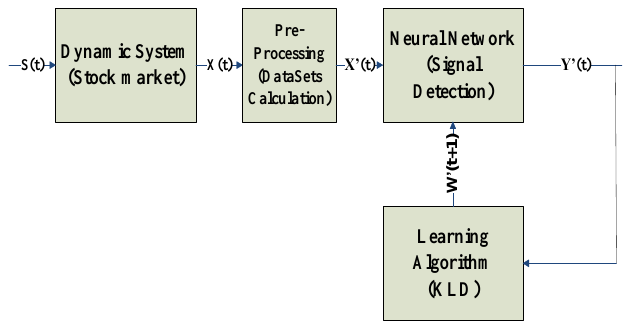
Fig. 1. Block diagram illustrating the proposed model